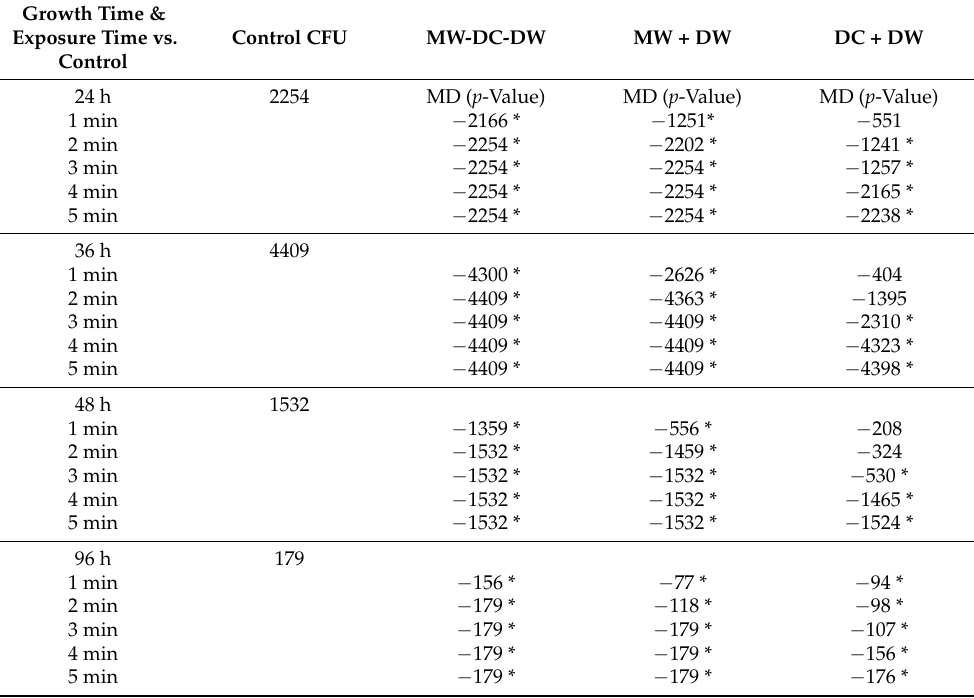
Table 1. Presenting Mean CFU difference among the test and control (non-disinfected) samples for E. coli . Growth Time & Exposure Time vs.